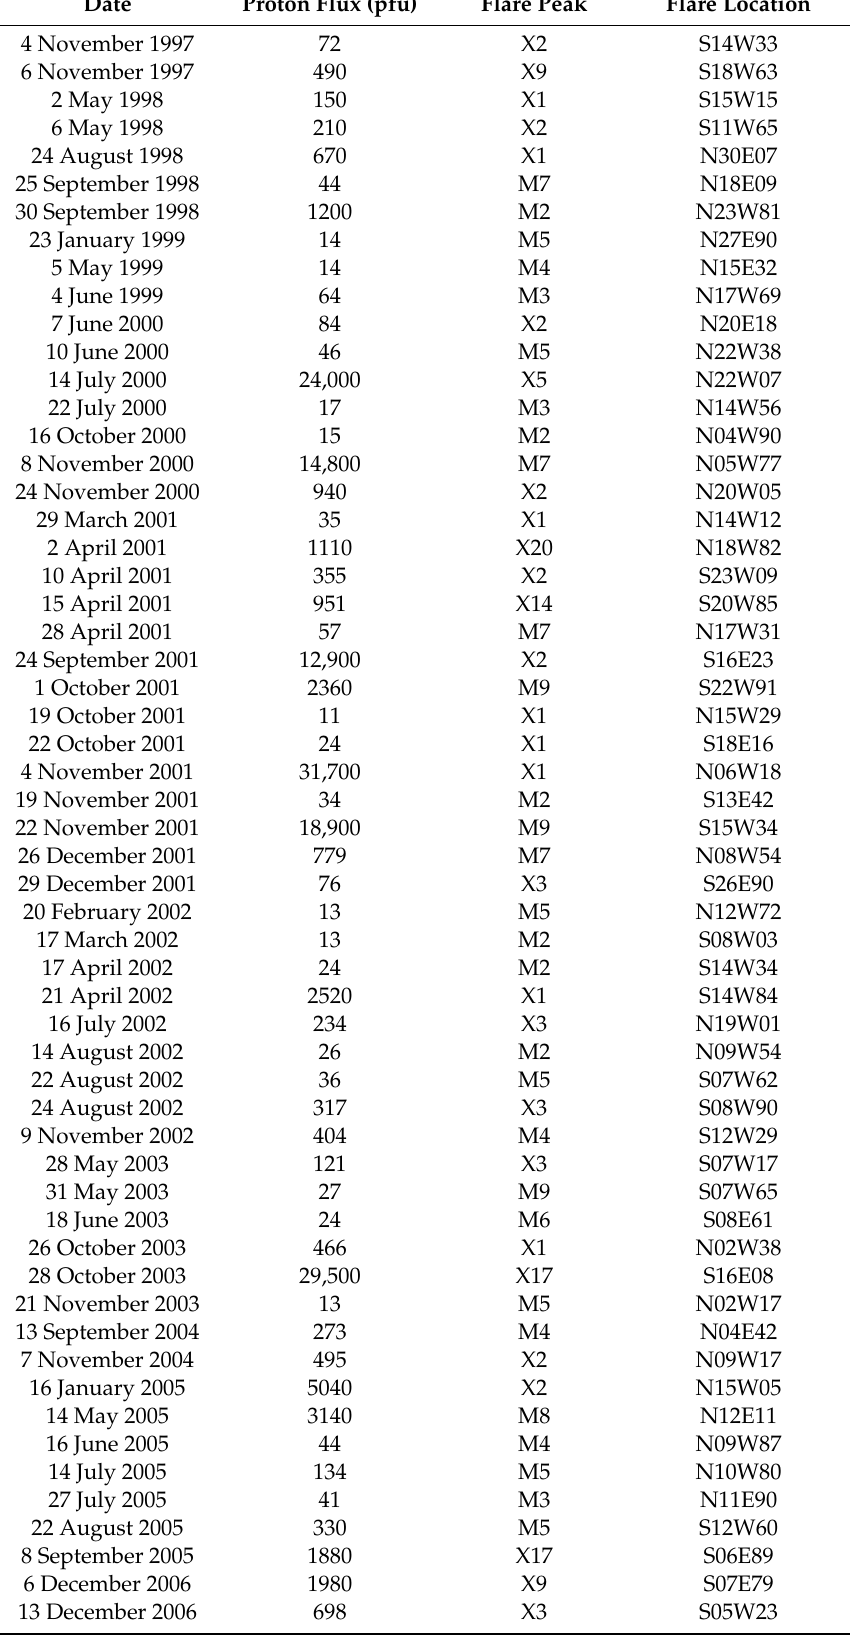
Table 2. List of events used in machine